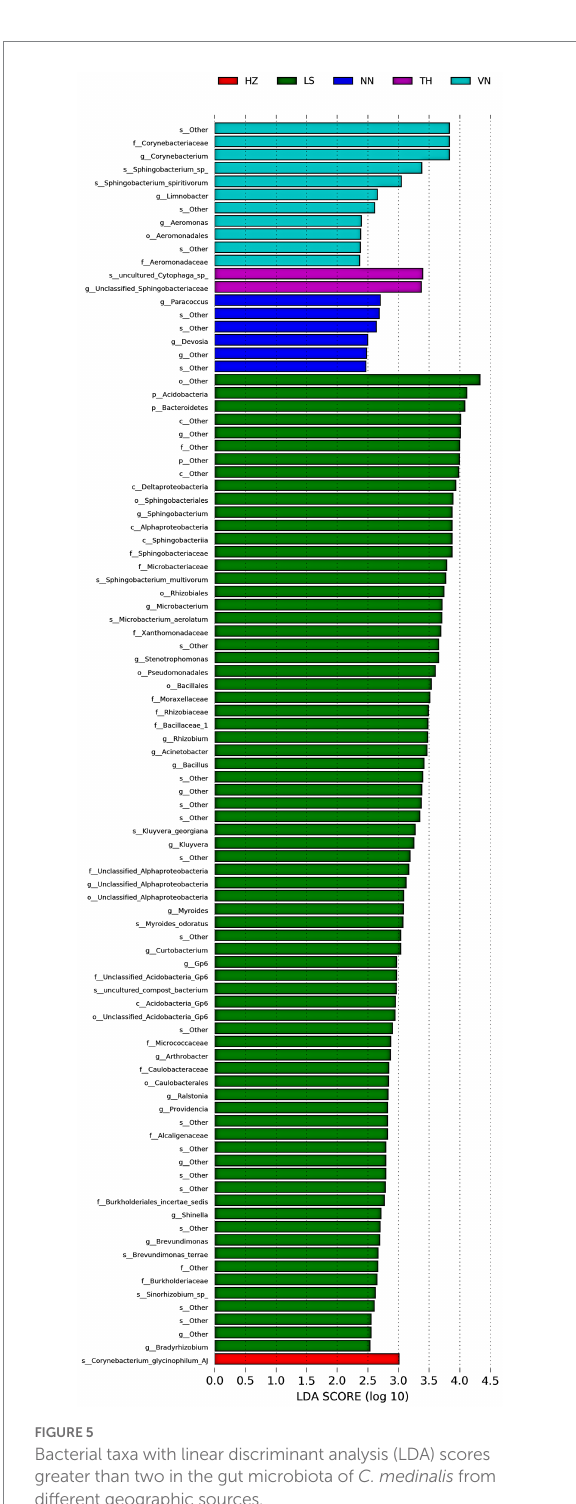
FIGURE 5 Bacterial taxa with linear discriminant analysis (LDA) scores greater than two in the gut microbiota of C. medinalis from different geographic